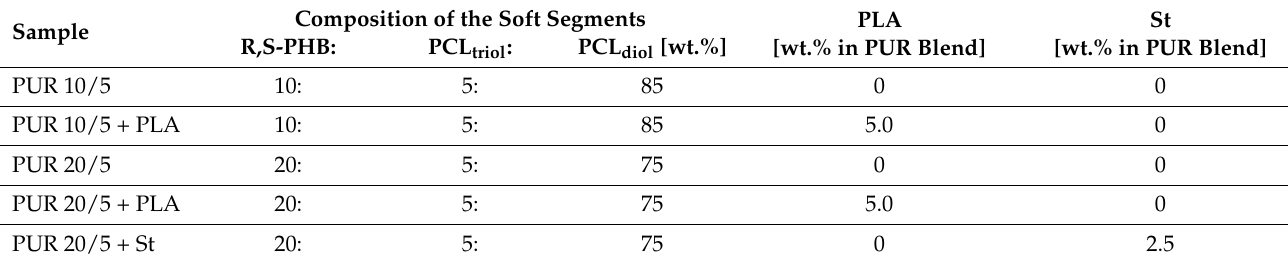
Scheme 3. Schematic image of the PUR-biopolymer blend. Table 1. Composition of polyurethanes and their blends. Table 1. Composition of polyurethanes and their